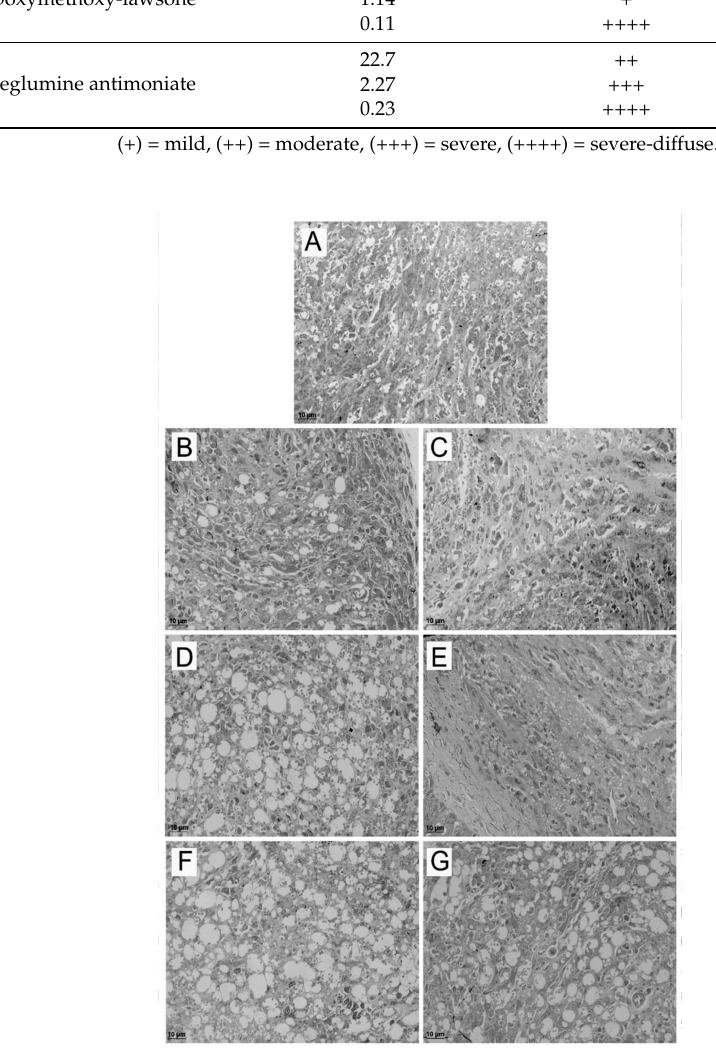
Figure 4. Analysis of mice lesions by light microscopy. Semithin sections of mice skin lesions of untreated ( A ) and treated groups with three doses of meglumine antimoniate ( B : 22.7 mg of Sb(V)/kg/day; D : 2.27 mg of Sb(V)/kg/day; F : 0.23 mg of Sb(V)/kg/day) and Epoxymethoxy-lawsone ( C : 11.4 mg/kg/day; E : 1.14 mg/kg/day; G : 0.11 mg/kg/day). Lesions were extracted one week after the end of a four weeks treatment course. The images are representatives of ten fragments of each group